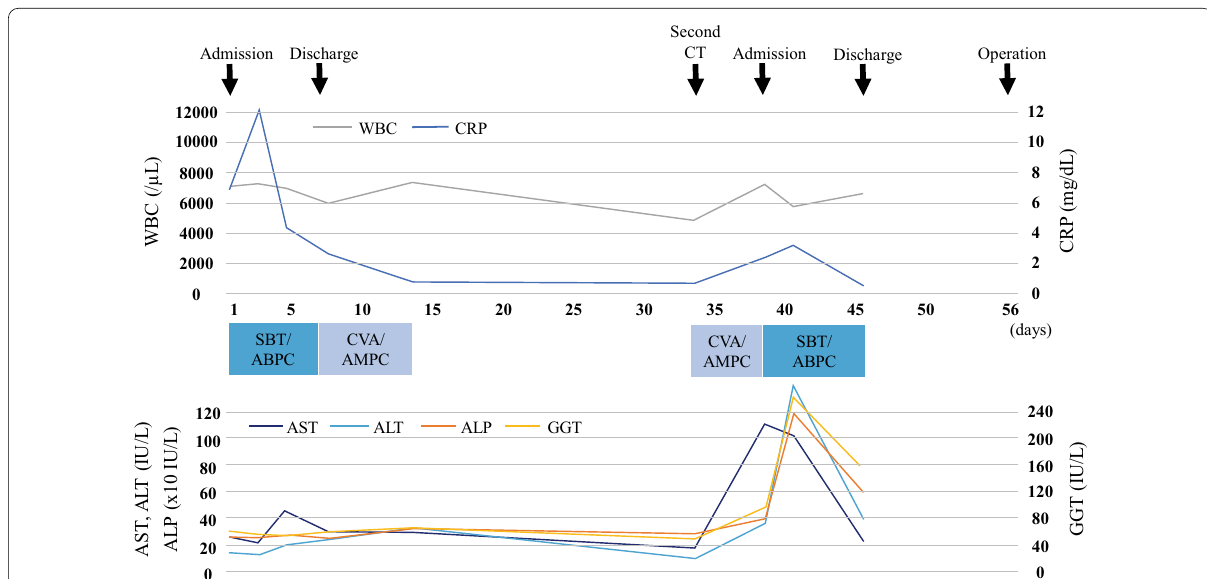
Fig. 4 The clinical course of the patient after the first admission till the operation. ALT alanine aminotransferase, ALP alkaline phosphatase, AST aspartate aminotransferase, CRP C-reactive protein, CT computed tomography, CVA/AMPC clavulanic acid/amoxicillin, GGT gamma-glutamyltransferase, SBT/ABPC sulbactam/ampicillin, WBC white blood